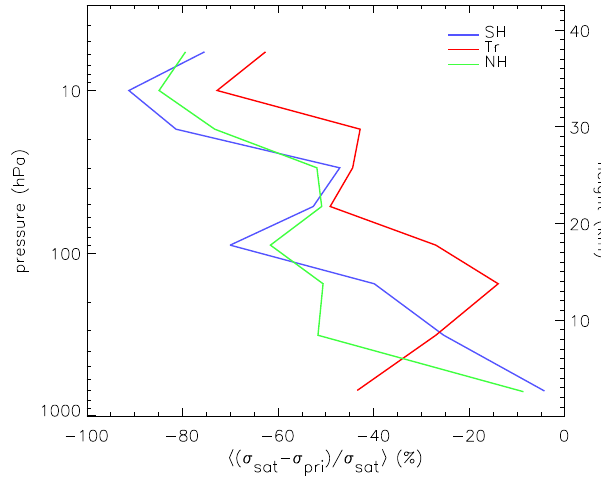
Fig. 3. Mean of the relative differences per latitude band for GOME retrievals. Error bars indicate the 95% confidence interval around the mean. The blue line gives the result for the Southern Hemisphere (SH), red for the tropics (Tr) and green for the Northern Hemisphere (NH) (solid for the retrieval, dashed for the a priori). The vertical dashed lines are accuracy levels for the troposphere and stratosphere defined in the ozone project of the ESA CCI programme.